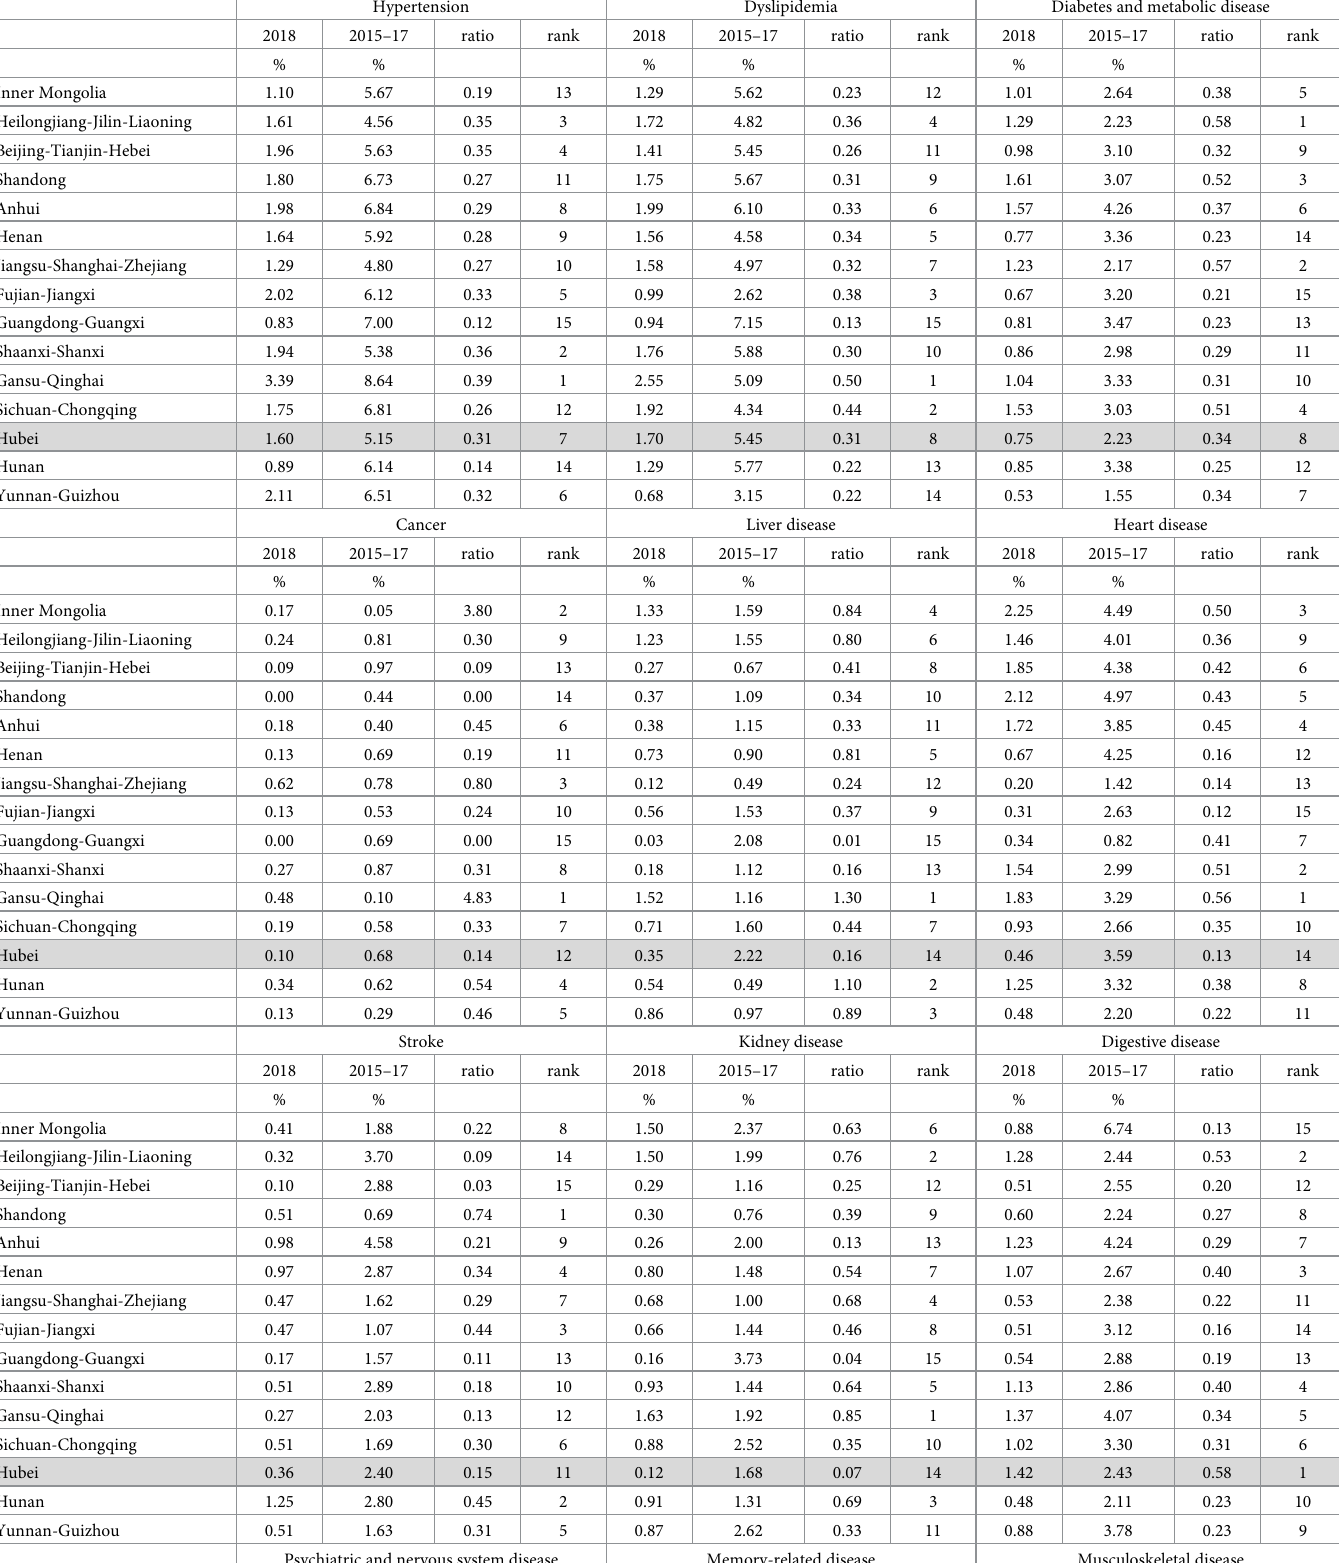
Table 4. Diagnosis of disease by year